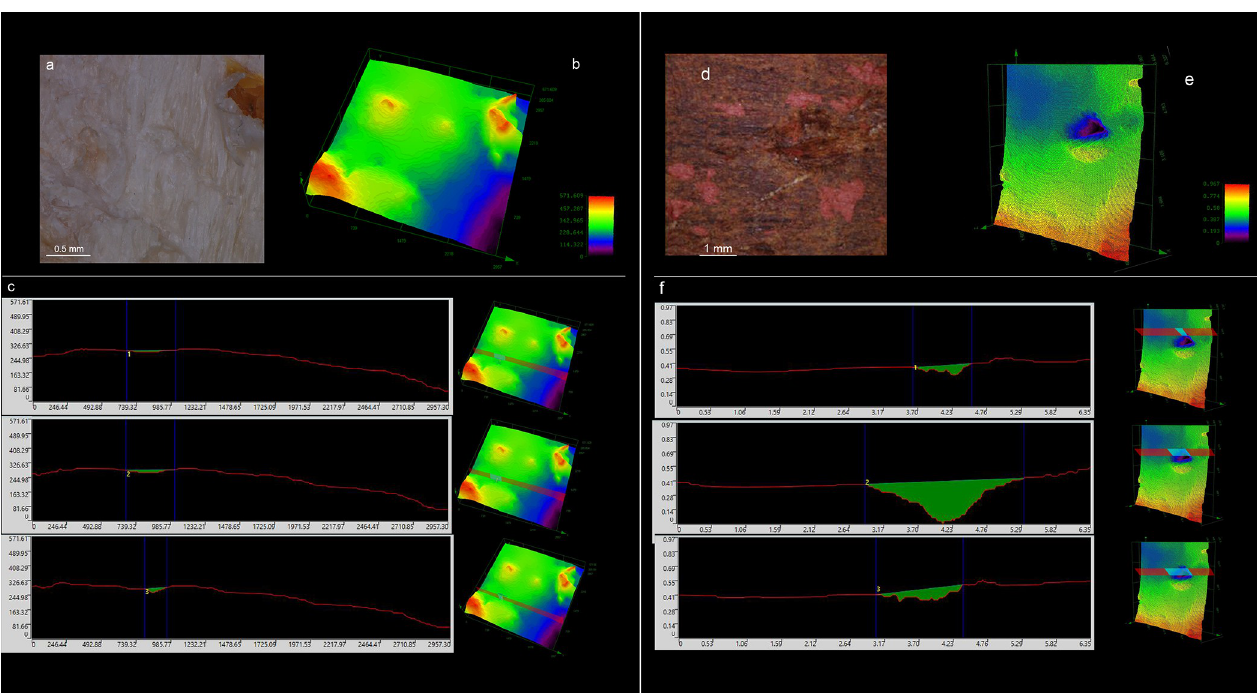
Fig 7. 3D analysis of a single punctiform impression on bone retoucher (left) and boomerang (right). (a) colour 2D image of a punctiform impression on bone retoucher (10x); (b) image of the same stigma with 3D height data; (c) U-shaped profile measurements and cross-section internal surface measured in different portions of the punctiform impression on bone retoucher; we can observe how the punctiform mark does not penetrate deeply in the bone surface. (d) colour 2D image of a punctiform impression on boomerang (3x); (b) image of the same stigma with 3D height data; (c) U-shaped profile measurements and cross- section internal surface measured in different portions of the punctiform impression on boomerang; we can observe how the punctiform mark penetrates deeply in the wooden surface, but it remains shallower than the linear impression.